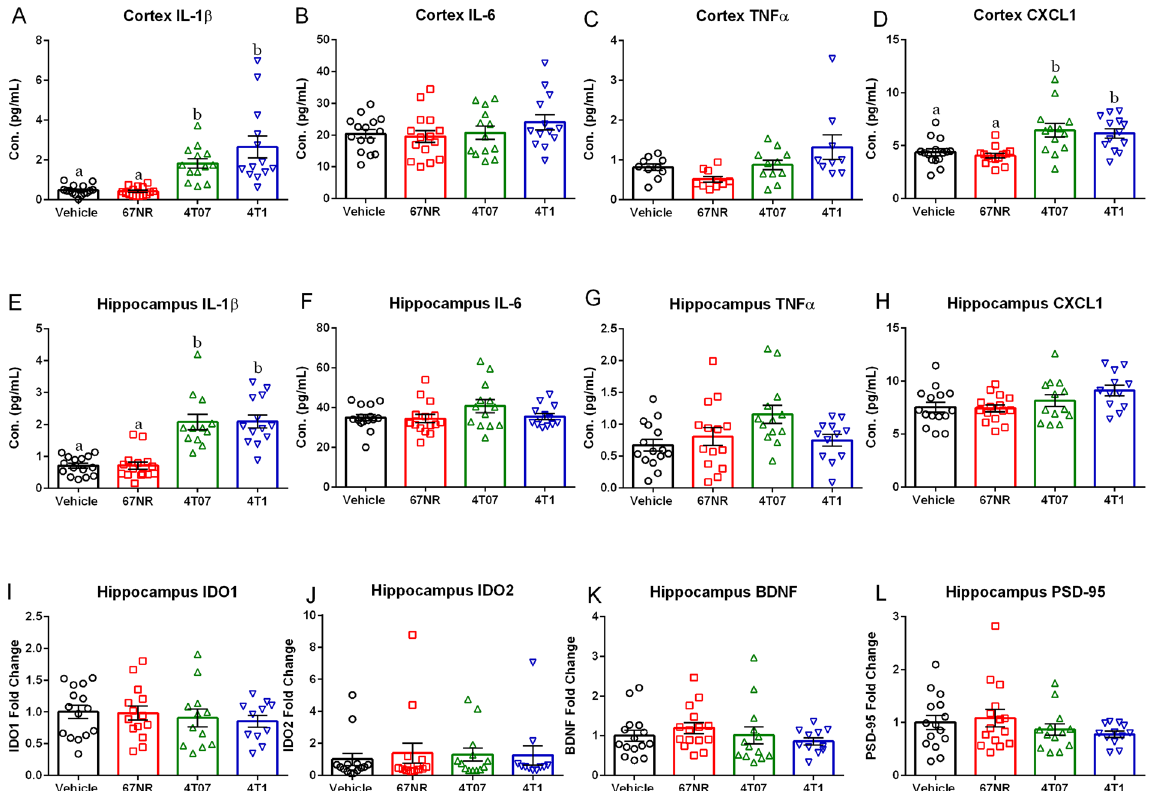
Figure 4. 4T07 and 4T1 Cell Lines Induce Central Pro-inflammatory Cytokine Production. ( A – D ) Cortex protein cytokine concentrations of IL-1 β , IL-6, TNF α , and CXCL1 expressed in both vehicle and treatment groups. ( A ) Cortex IL-1 β was significantly increased in 4T07 and 4T1 tumors relative to 67NR tumors and vehicles. ( B ) There were no significant differences in cortex IL-6 ( C ) Cortex TNF α was significantly increased in 4T1 tumors relative to 67NR tumors. ( D ) Cortex CXCL1 was significantly increased in 4T07 and 4T1 tumors relative to 67nR tumors and vehicles. ( E – H ) Hippocampus protein cytokine concentrations of IL-1 β , IL-6, TNF α , and CXCL1 expressed in both vehicle and treatment groups. ( E ) Hippocampus IL-1 β was significantly increased in 4T07 and 4T1 tumors relative to 67NR tumors and vehicles. ( F ) There were no significant differences in hippocampal IL-6. ( G ) Hippocampal TNF α was significantly increased in 4T07 tumors relative to vehicles. ( H ) There were no significant differences in hippocampal CXCL1. ( I – L ) mRNA levels expressed as fold change from vehicles for IDO1 (enzyme implicated in etiology of depression), IDO2 (enzyme implicated in etiology of depression), BNDF (neurotrophin), and PSD-95 (marker of postsynaptic densities); There were no significant differences in mRNA expression of IDO1, IDO2, BDNF, or PSD-95. The measures and tissues were collected 20 days after tumor cell or vehicle inoculation (n = 12–15/group). The data are presented as mean + SEM. Graph bars that do not share a letter are statistically significant different at p <